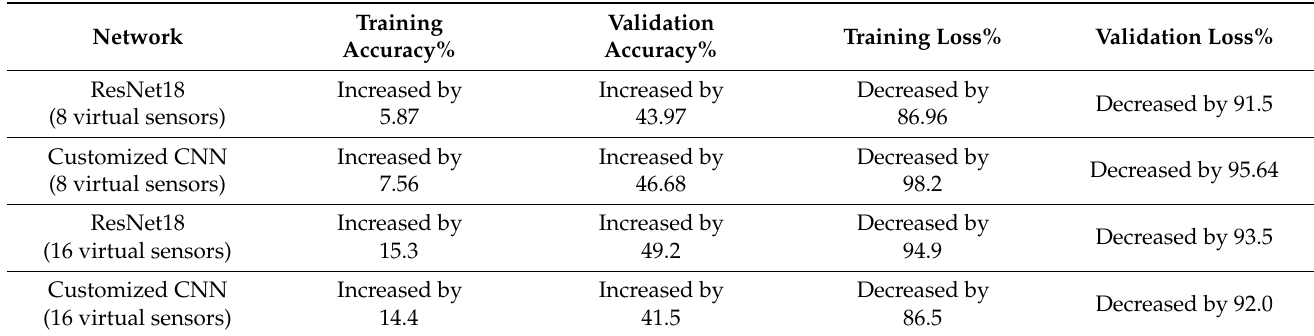
Table 4. Improvement in the classification performance due to data augmentation in comparison with the original data without